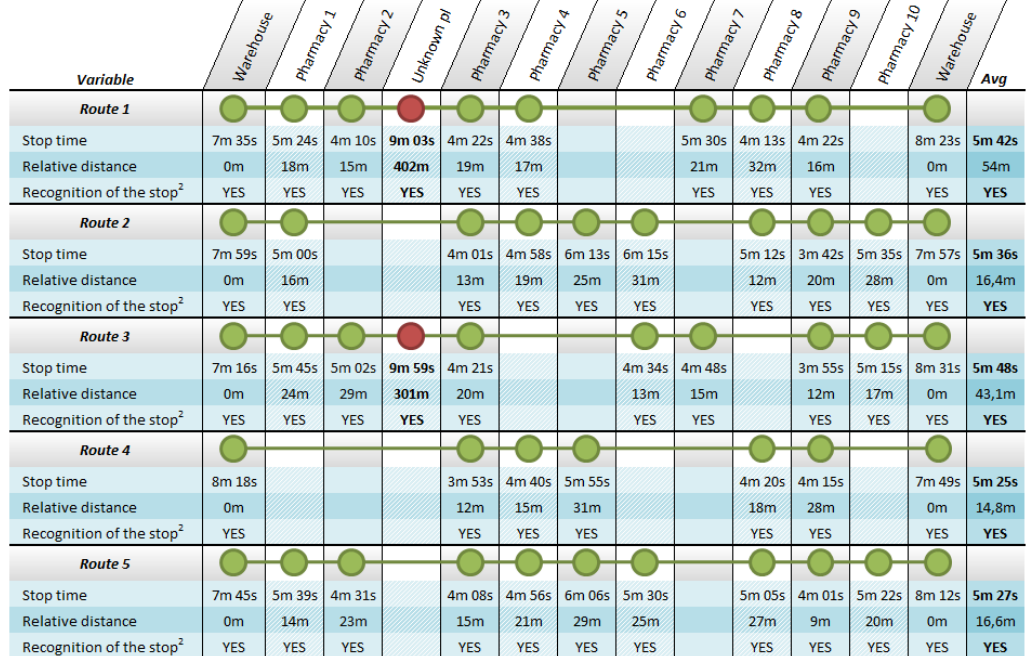
Figure 14. Results of the first phase of system validation: the positioning system. In the table, stop time row shows the duration of the stop from the van parked until the route resumes; relative distance row shows the distance between the position of the van at each stop and the nearest pharmacy on route; and recognition of the stop row indicates whether the stop is identified with the associated